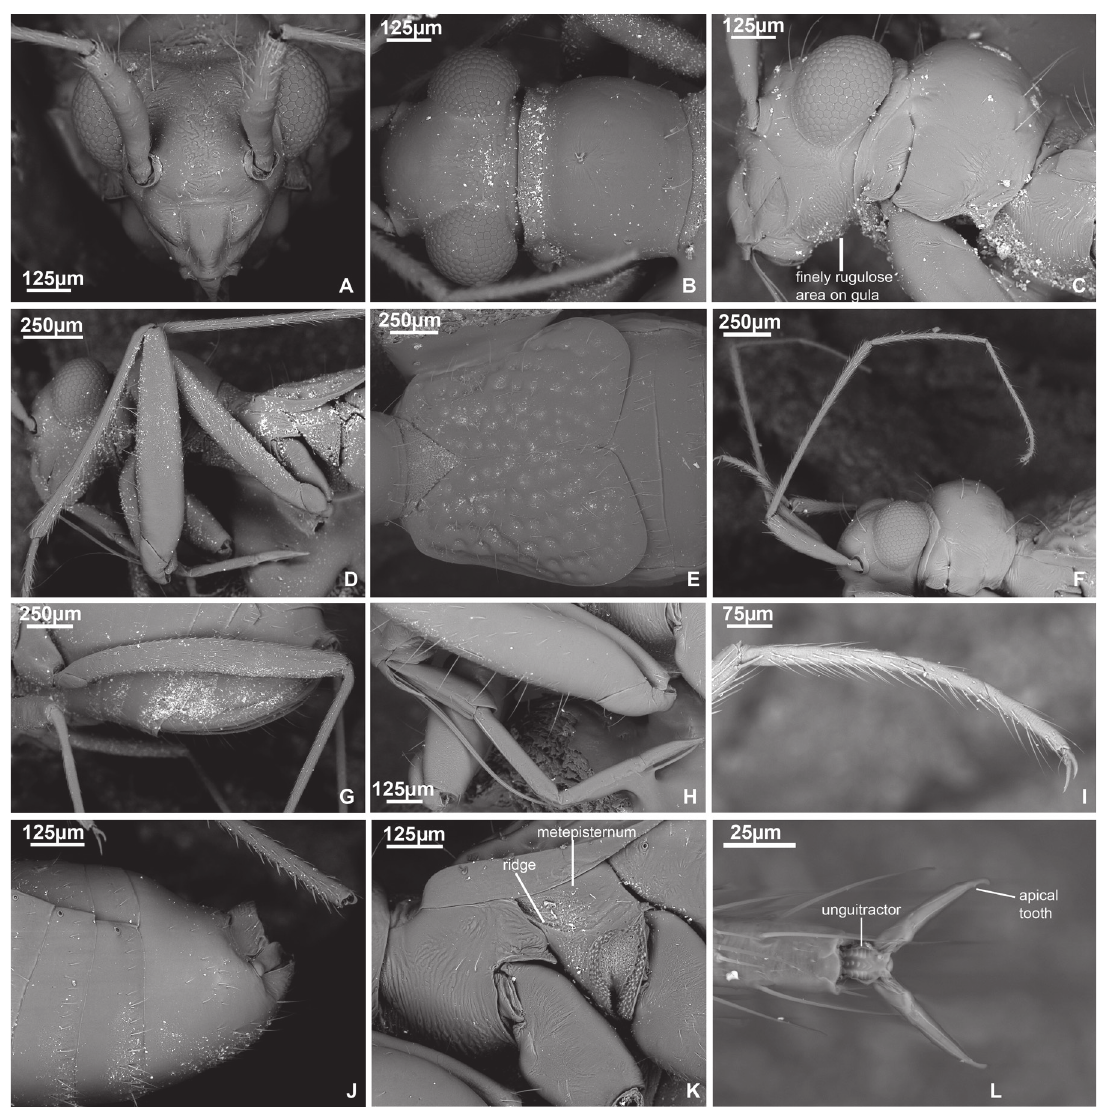
Fig. 2. SEM images of C. malcolmae Slater & Gross, 1977. A . Head, anterior view, ♀. B . Head and pronotum, dorsal view, ♂. C . Head and pronotum, lateral view, ♀. D . Fore- and middle femora, ♂. E . Scutellum and hemelytra, ♀. F . Antenna, ♀. G . Hind femur, ♀. H . Labium, ♀. I . Hind tarsus, ♀. J . Abdomen, lateral view, ♂. K . Pleura, ♀. L . Pretarsus, ventral view,